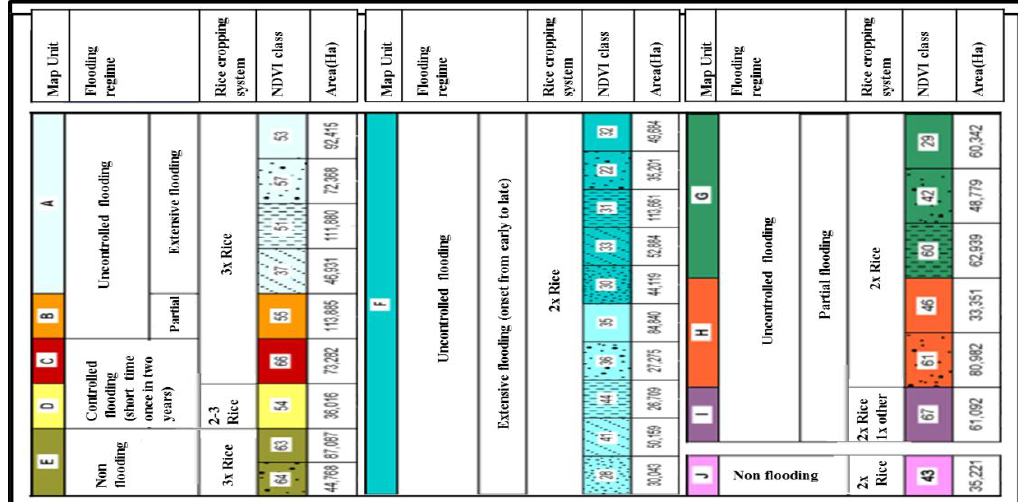
Figure 4. The NDVI rice unit map.